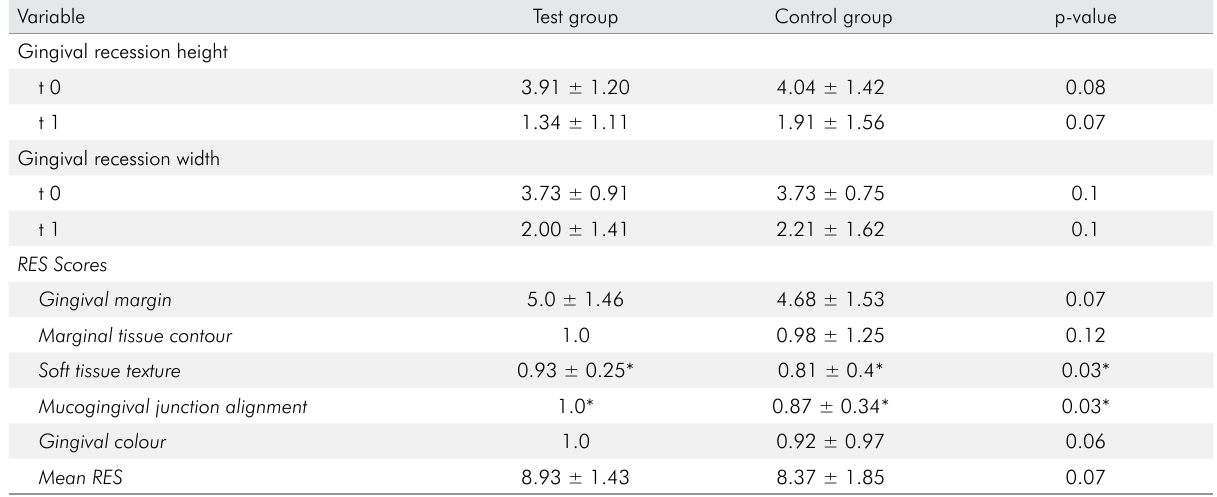
Table 2. Gingival recession height, gingival recession width, RES scores, and mean RES (t0: pre-treatment, t1: after 1 year of treatment).